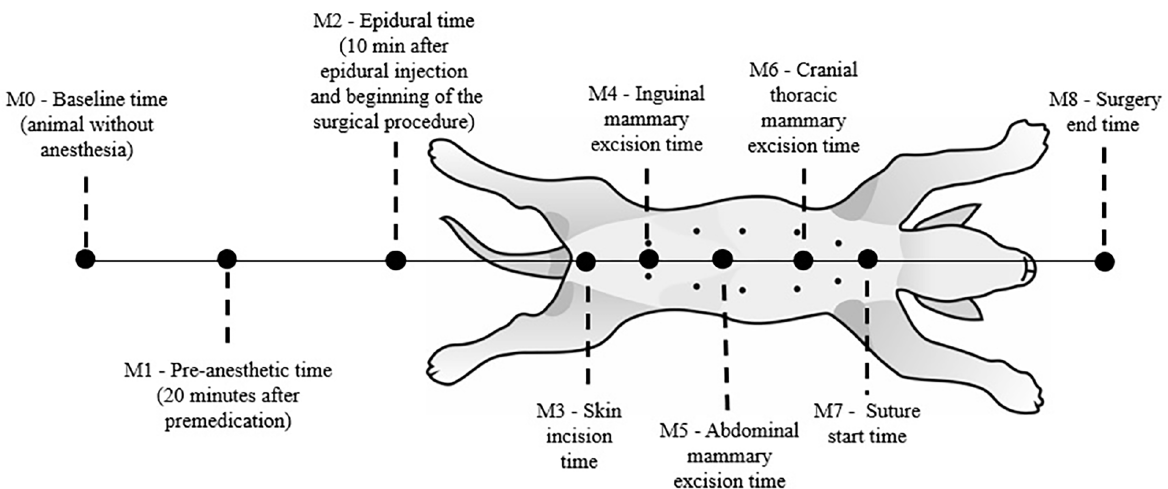
Figure 1. Schematic demonstration of the moments of recording cardiorespiratory parameters, according to the location of the